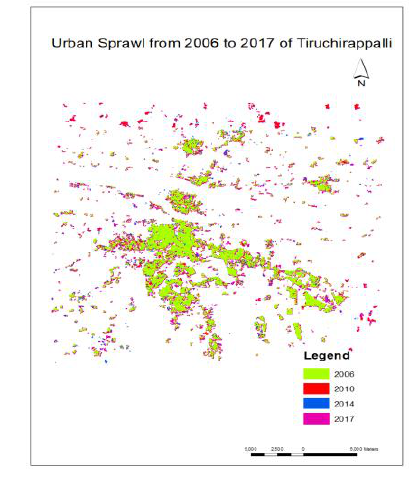
Figure 3. Urban Sprawl from year 2006-2017 Shannon’s entropy was calculated from the built-up area for each individual zone (n=52). The value of entropy for Tiruchirappalli for 2006 was 3.85 and for 2017 was 3.88 while log(n) for n=52 value is 3.95. The value of entropy is close to log(n) hence it shows high degree of dispersion in urban areas